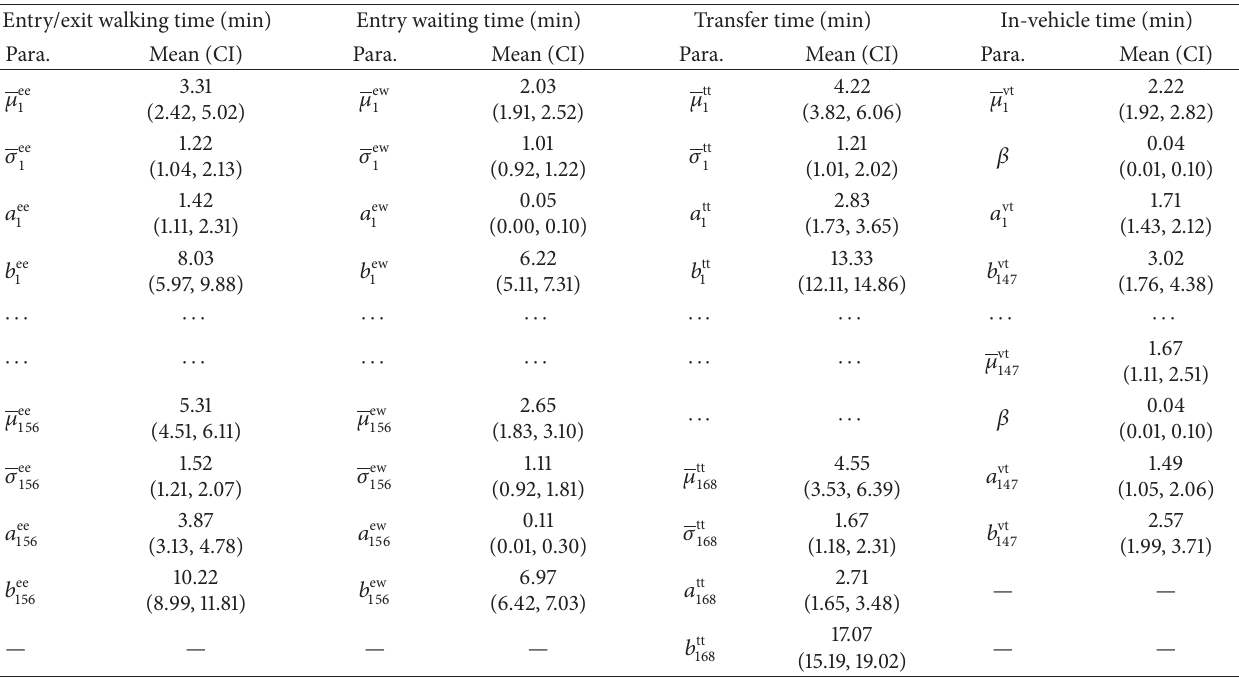
Table 2: The estimations of some